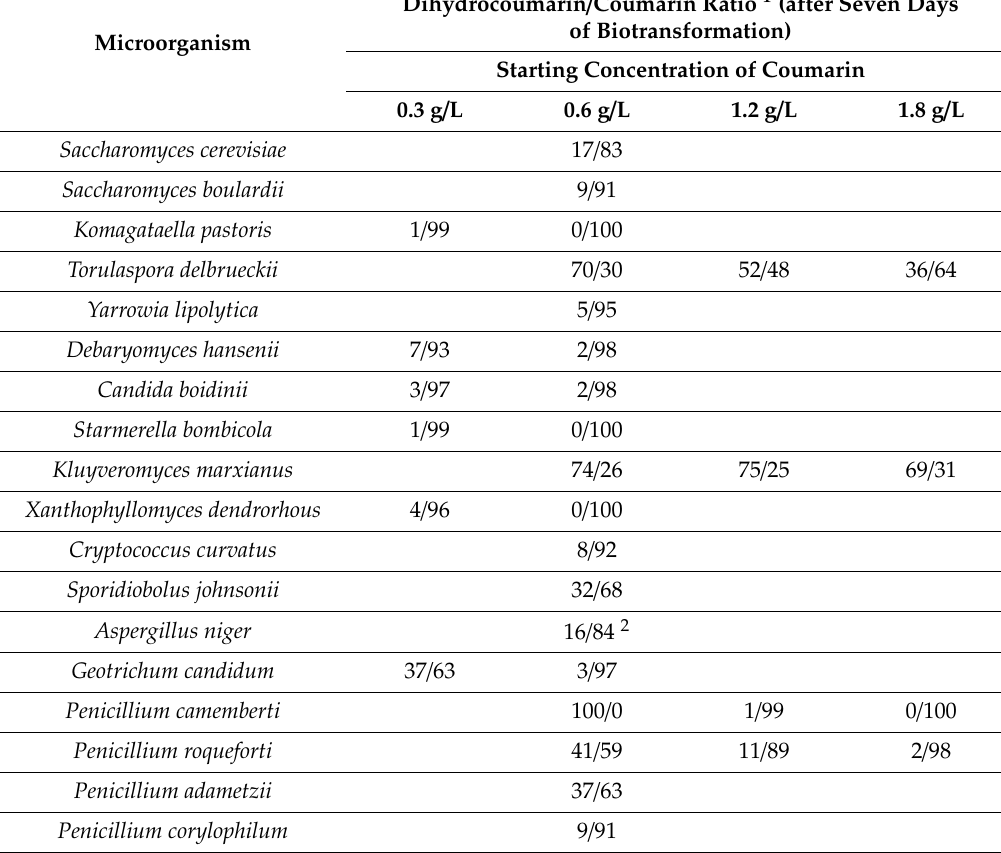
Table 1. Results of the microbial biotransformation of coumarin.